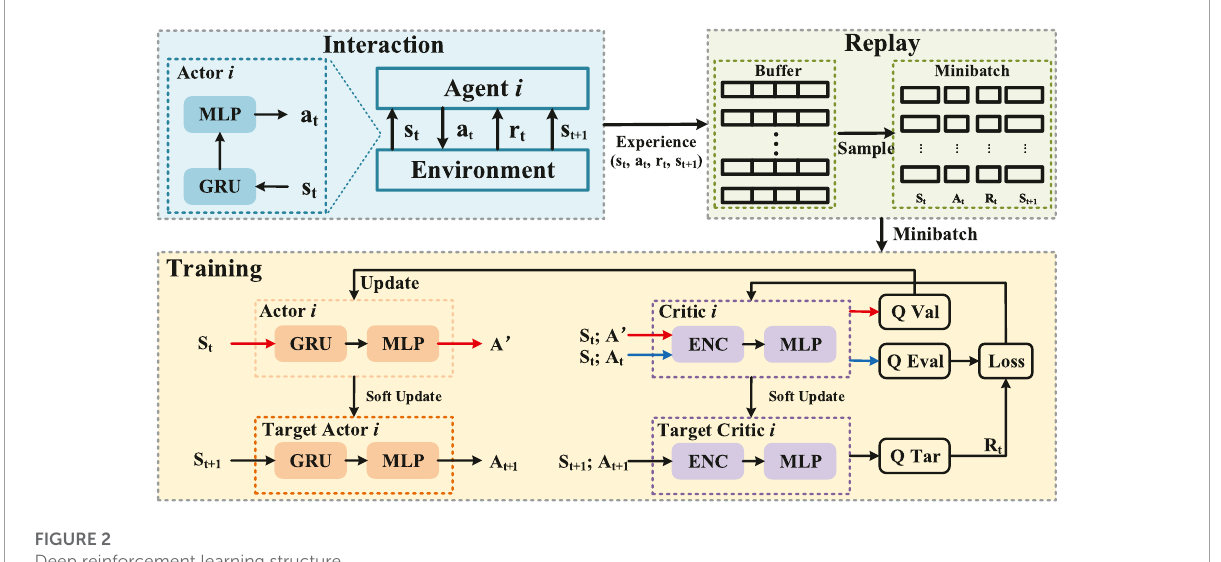
FIGURE 2 Deep reinforcement learning structure.